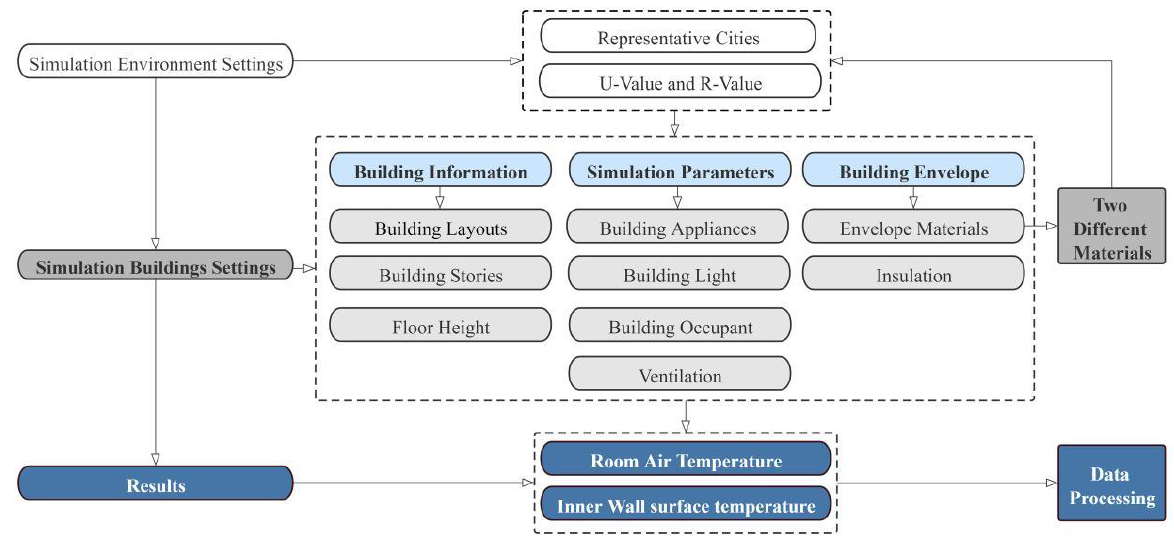
Figure 3. Flowchart for the building simulation.